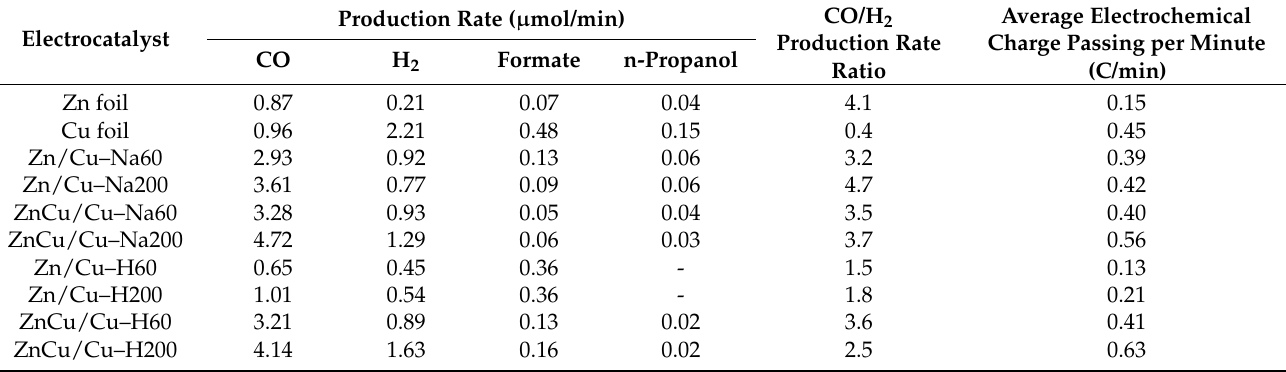
Table 2. Catalytic performances of electrocatalysts with different deposition times at a reaction potential of − 1.6 V vs. Ag/AgCl for 70 min.